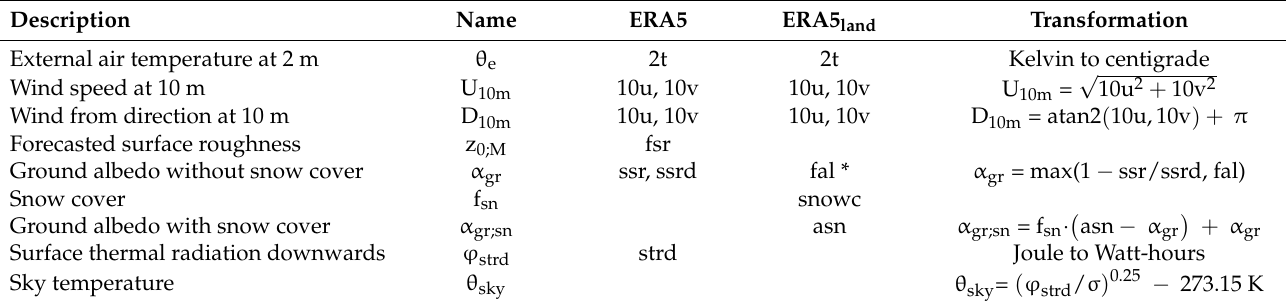
Table 2. Climate variables acquired from ERA5 and ERA5-land reanalysis and the model transformation. The name of each variable used in the comparison study is shown on the same line as the sourced variables according to their short names in the Copernicus